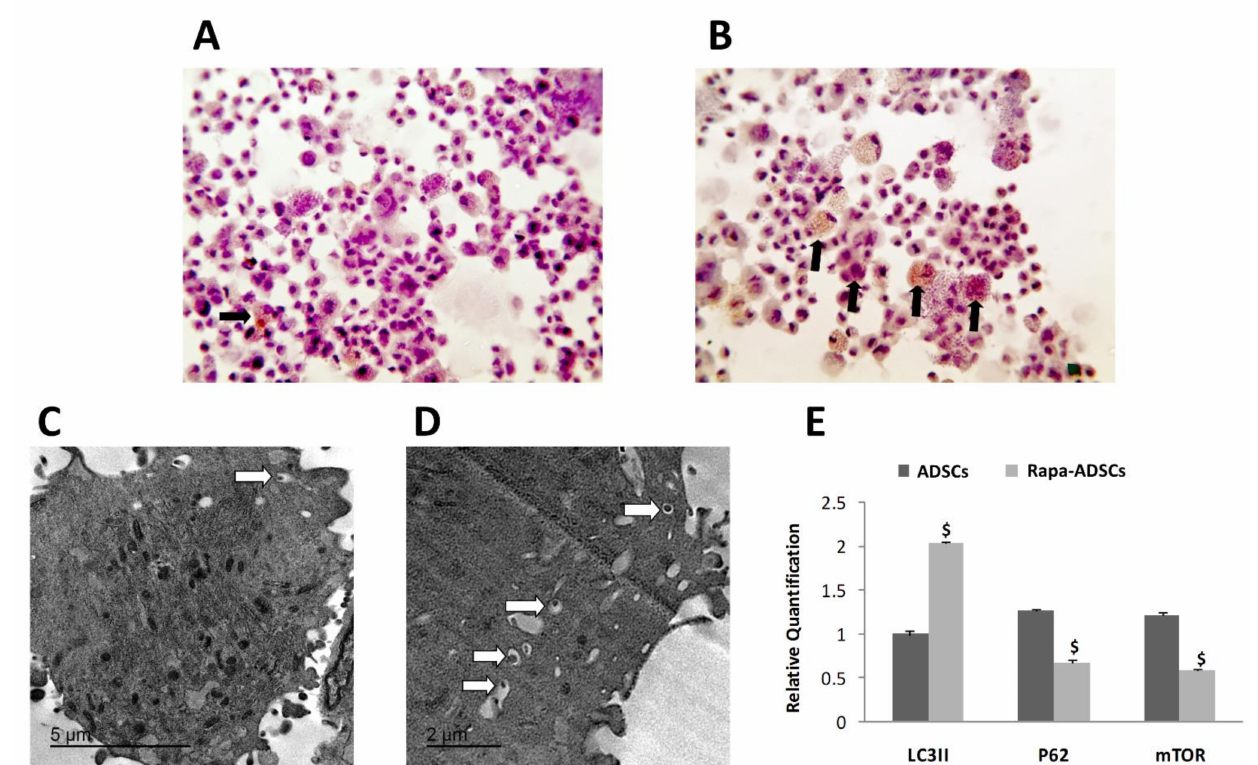
Figure 2. The effect of rapamycin preconditioning on autophagosomes formation in ADSCs. ( A , B ) Autophagosomes are immunohistochemically labeled with LC3II antibodies; magnification 400 × . Black arrows indicate LC3II-positive autophagosomes inside ADSCs. ( A ) Non-preconditioned ADSCs, ( B ) Rapamycin (50 nM/L) preconditioned ADSCs. ( C , D ) The effect of rapamycin preconditioning on autophagic ultrastructures; white arrows indicate autophagosomes. ( C ) Non-preconditioned ADSCs, ( D ) Rapamycin (50 nM/L)-preconditioned ADSCs. ( E ) Effects of 50 nM/L rapamycin on expression of LC3II, p62 and mTOR genes in non-preconditioned and preconditioned ADSCs. Statistical significance, $ = p <